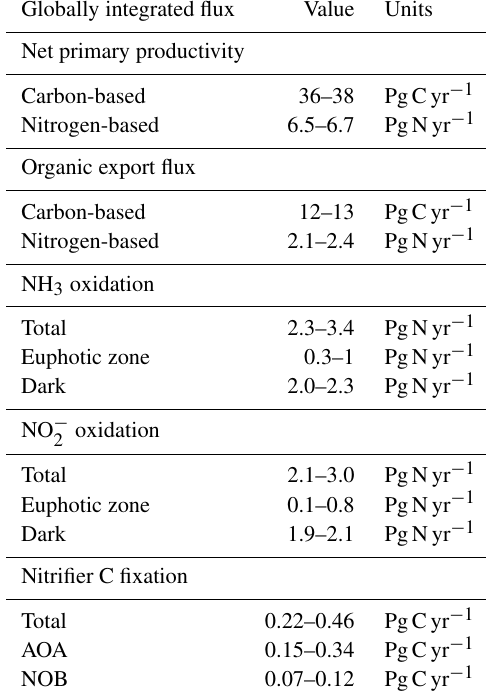
Table 3. Globally integrated rates from the global ecosystem model (Darwin-MITgcm). The range of nitrification and associated C fix- ation rates reflects sensitivity to the range of yield and population loss rate parameters of the modeled AOA and NOB functional type populations across multiple simulations. Export is calculated as the flux of particulate organic matter at the base of the euphotic zone (the 1% light level). The range of export values reported reflects the choice of cutoff of unrealistically high values in coastal waters and remains the same across the multiple